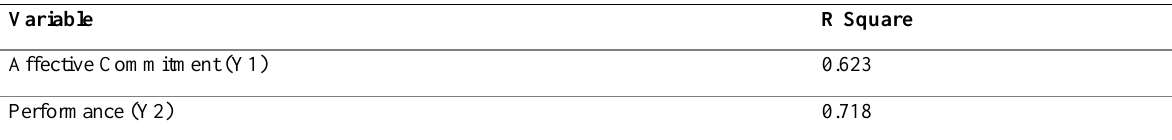
Table 18: R-Square Value